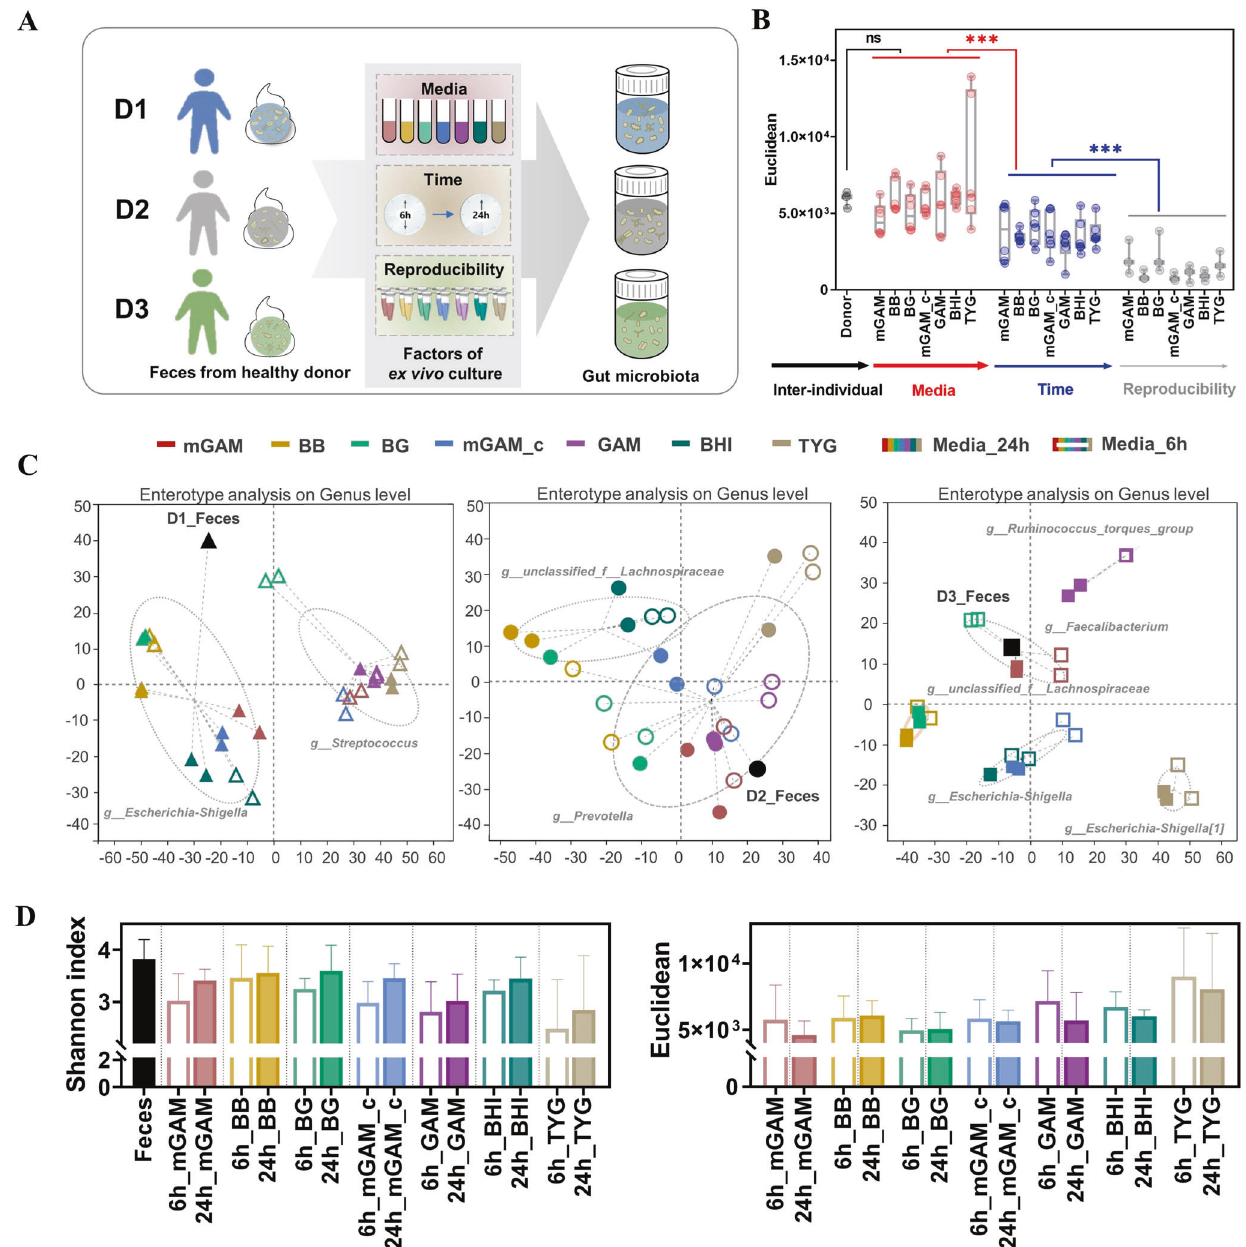
Fig. 2 Evaluating the ex vivo culturing system for human-fecal samples. A Flow chart of the experiment B . Euclidean of factors at the ASV level C Enterotype of fecal sample and its cultures. D Shannon index and Euclidean at the ASV